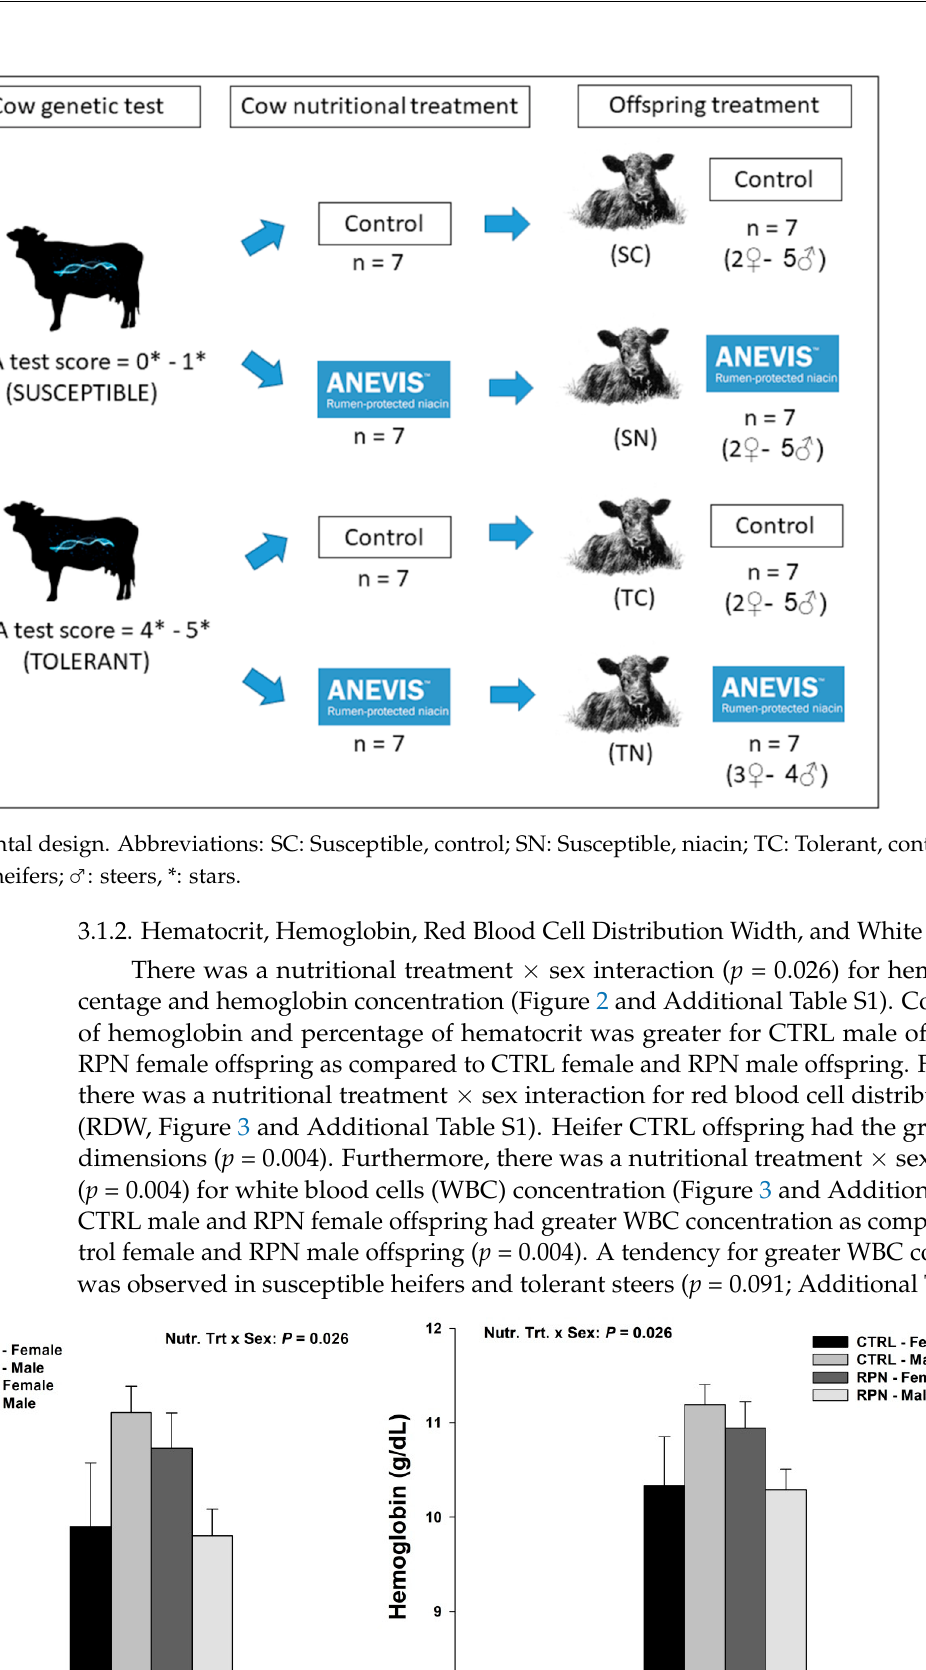
Figure 2. Significant nutritional treatment and sex interactions for hematocrit, hemoglobin, red blood cell distribution width, and white blood cells of Angus × Simmental steers and heifers’ offspring. Hematocrit is represented by the percentage of packed red cells in the blood, hemoglobin (g/dL), red blood cell distribution width (RDW, %), and white blood cells (×10 3 /uL) results of Angus × Simmental steers (male) and heifers (female) exposed to diets containing rumen- protected niacin (RPN), or without rumen-protected niacin (CTRL), and endophyte-infected tall fescue seeds. Statistically significant differences were declared at p < 0.05 and tendencies at p > 0.05 and <0.1. 3.1.3. Mean Corpuscular Hemoglobin, Mean Corpuscular Volume, Neutrophils and White Blood Cells There was a genetic treatment × nutritional treatment interaction for mean corpuscular hemoglobin and mean corpuscular volume ( p = 0.013 and p = 0.031, respectively) with greater concentrations for SC offspring and lower concentration for SN offspring (Figure 3 and Additional Table S1). There was a genetic treatment × nutritional treatment interaction ( p = 0.043) for neutrophil with greater concentration for TN offspring. Finally, there was a genetic treatment × nutritional treatment significant interaction ( p = 0.003) for white blood cells with greater concentrations for SC and TN offspring (Figure 3 and Additional Table S1).